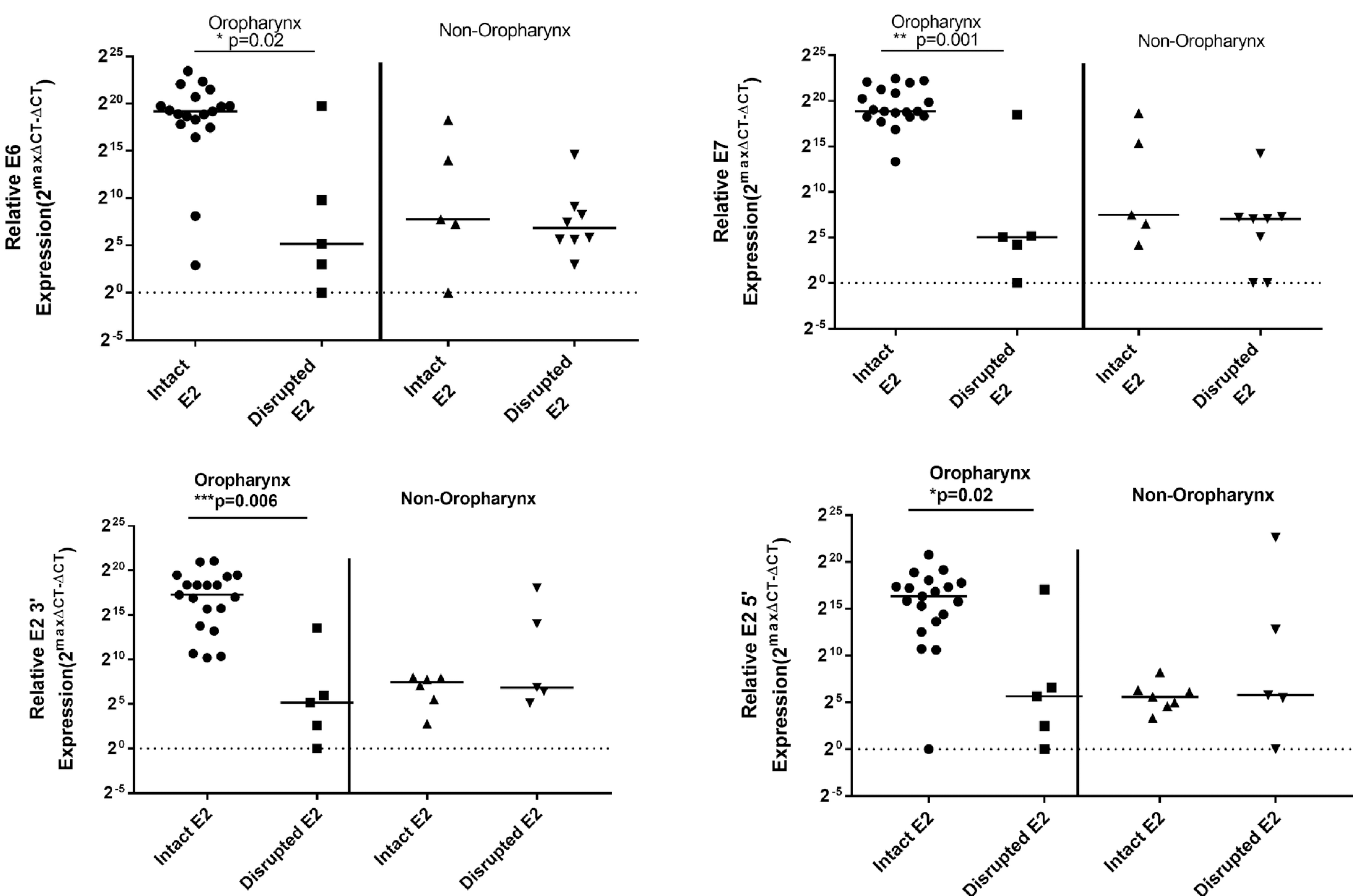
Fig 2. HPV16 E6, E7 and E2 are overexpressed in OPSCCs with an intact E2 . HPV16 E6 (A) and HPV16 E7 (B) expression with HPV16 E2 gene disruption. Expression is defined as Y = 2 max Δ CT- Δ CT where max Δ CT is the lower limit threshold of detection which equals 20 or 1. Δ CT is the experimental value minus the endogenous control (GAPDH). Statistical significance for difference in HPVE6 and E7 expression by site and between samples with an intact or disrupted HPV16 E2 gene was assessed by Mann-Whitney test.